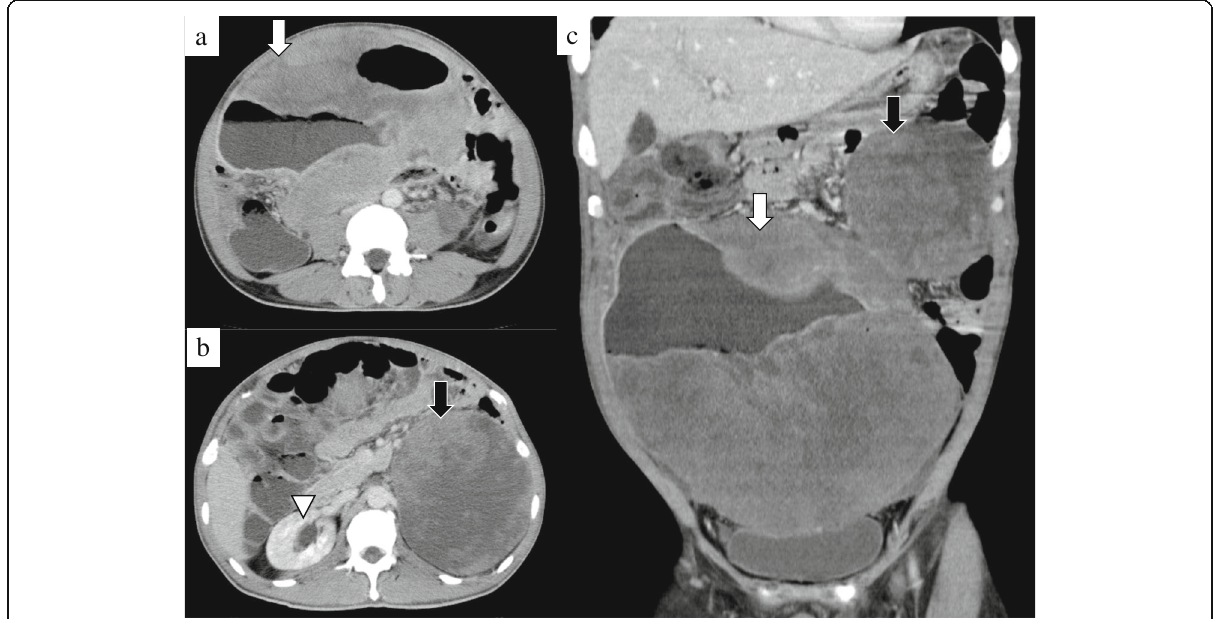
Fig. 1 An abdominal enhanced computed tomography scan. a An intra-abdominal mass with a diameter of 230 mm (white arrow). The dorsal part of the intra-abdominal tumor contained liquid and air, which indicated abscess formation. b A retroperitoneal mass under the left kidney with a diameter of 146 mm (black arrow), intra-abdominal tumor compressed the right ureter, and the right kidney was in hydronephrosis state (white arrowhead). c Both tumors had internal inhomogeneity, and the upper part of the intra-abdominal tumor would contain abscess (white arrow, intra-abdominal tumor; black arrow, retroperitoneal